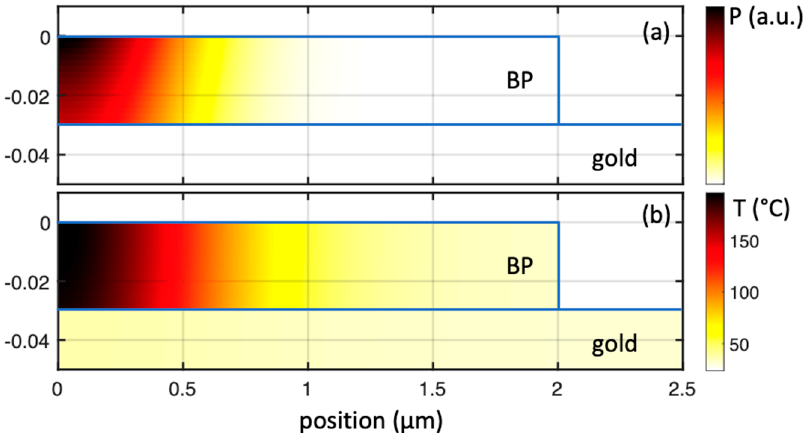
Figure 4. Finite-element simulation of the heating effects of a laser focused on a 30 nm thick layer of black phosphorus on top of a gold-on-mica substrate. The figure is magnified in the black phosphorus region. The position in (0, 0) corresponds to the center of the illumination. The vertical scale is expanded with respect to the horizontal scale for clarity. ( a ) Local illumination power density. ( b ) Spatial distribution of the induced local temperature.